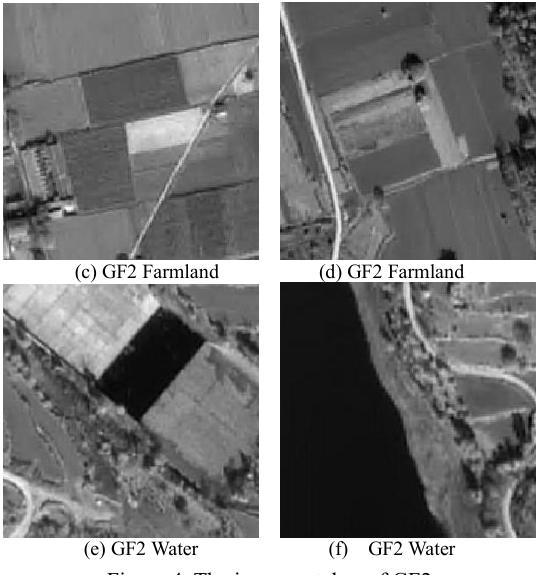
Figure 4. The image patches of GF2